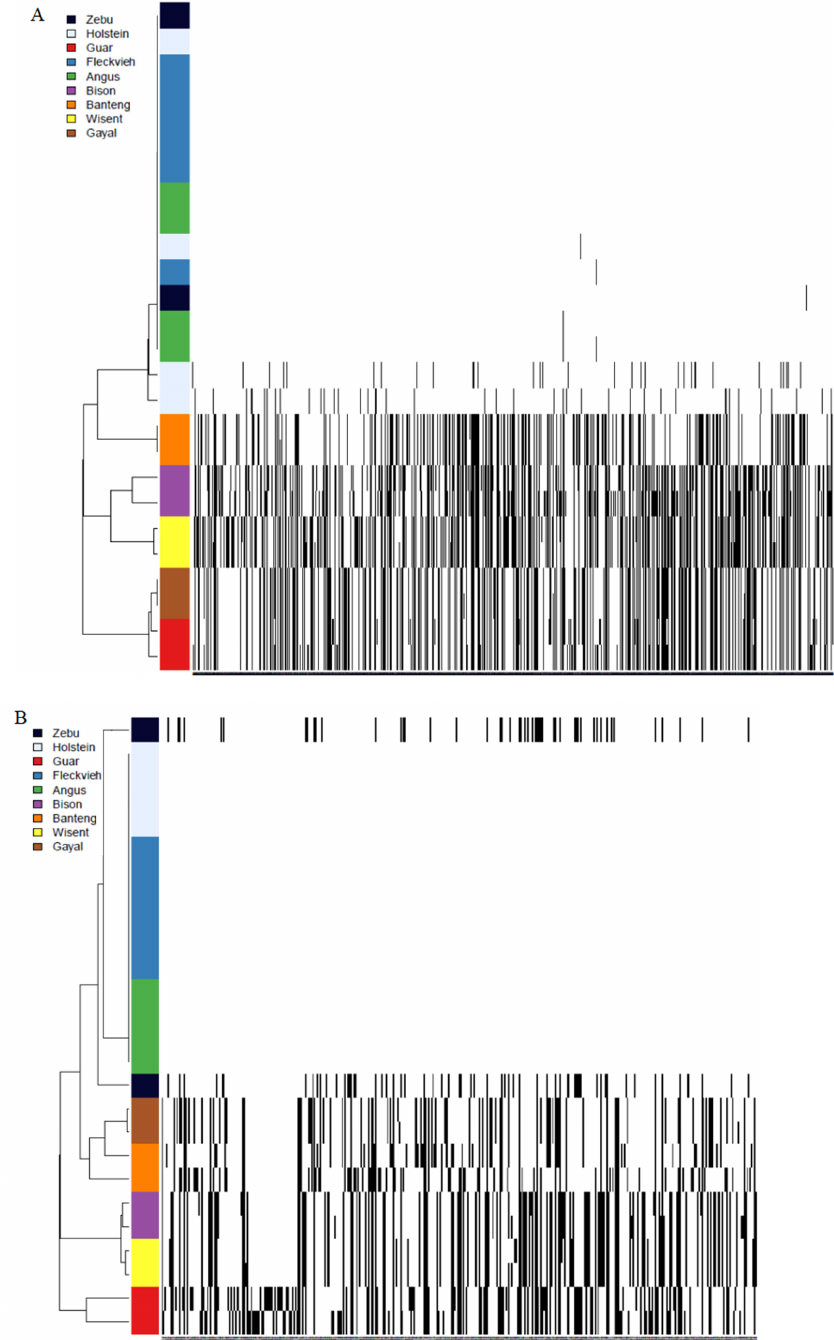
Figure 6. Haplotype structure and phylogenies of haplotypes from an ROH hotspot region contain- ing the RERE gene for Bos taurus (Holstein, Angus and Fleckvieh), Zebu ( Bos indicus) , Gaur, Bison, Banteng, Wisent and Gayal. ( A ) Left panel: the phylogeny of RERE haplotypes. Haplotypes are clus- tered based on based on the Manhattan distance, bringing together similar haplotypes and ordered by decreasing similarity. Right panel: the haplotype structure around the RERE gene. Colored blocks indicate the origin of haplotypes. The two alleles at each bi-allelic SNP are shown as black or white lines. ( B ) Left panel: the genealogy of SLC25A51 haplotypes. Right panel: the haplotype struc- ture around the SLC25A51 gene. Colored blocks indicate the origin of haplotypes. The two alleles at each bi-allelic SNP are shown as black or white lines.